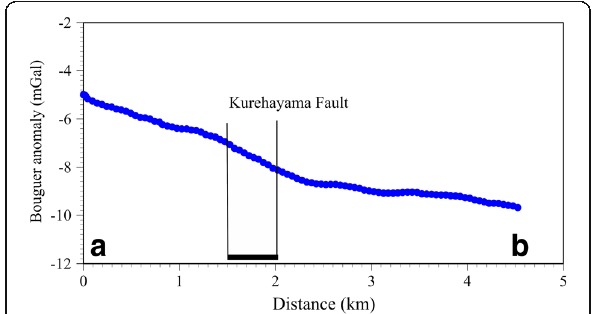
Fig. 8 Bouguer anomalies on the profiles (after Toyama City 2013). The Bouguer density of 2260 kg/m 3 is assumed. The “ Kurehayama Fault ” shown in this figure indicates a rough fault location by Toyama City (Toyama City 2013). The unit of the gravity anomaly is given in milligal, and mGal =10 − 5 m/s 2